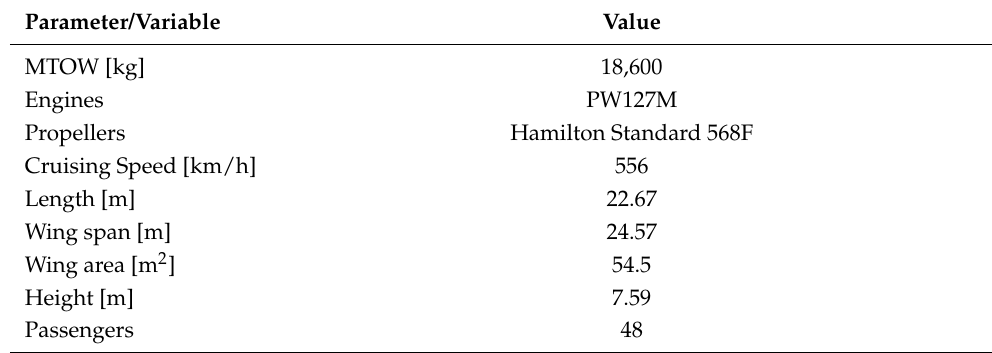
Table 1. Main characteristics of the ATR42-600, data from [21].